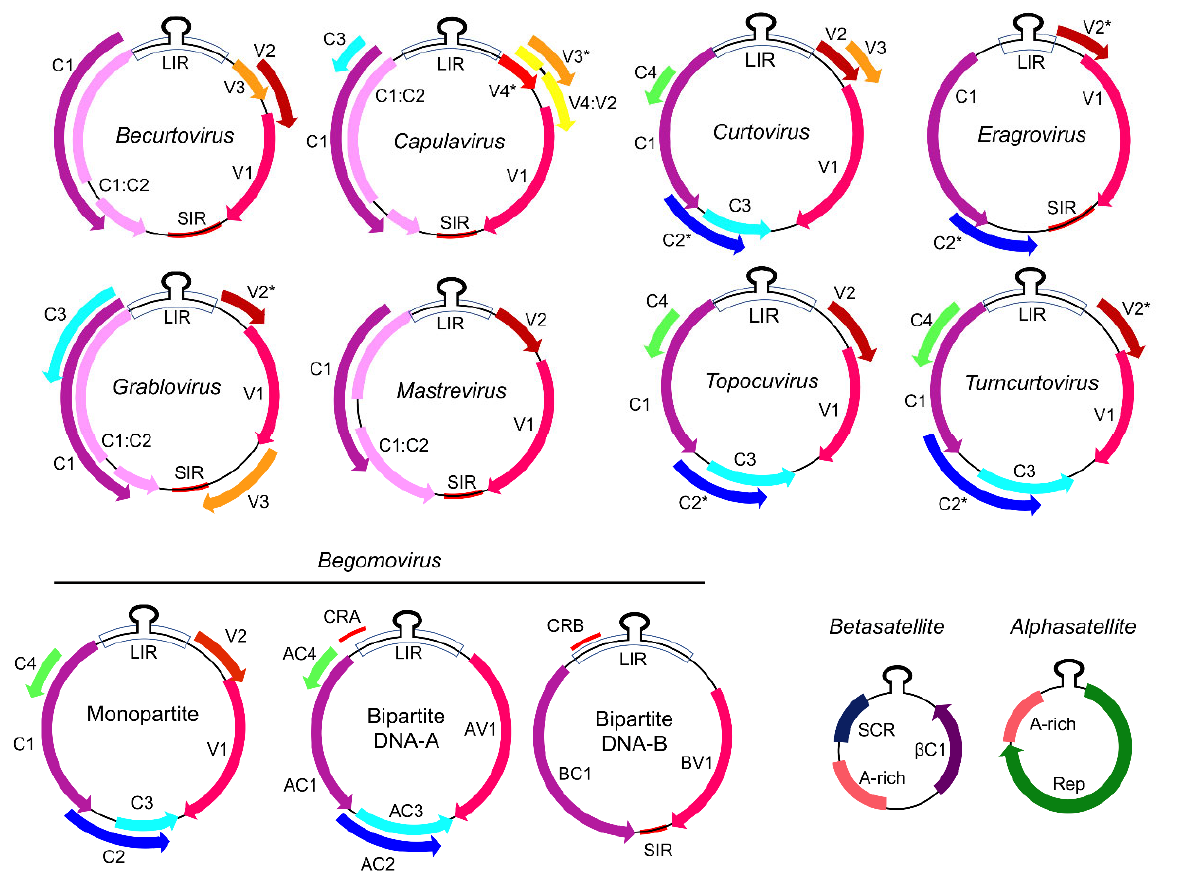
Figure 1. Genomic organization of geminiviruses (Geminiviridae family). The Geminiviridae family includes nine genera represented by monopartite or bipartite species. LIR denotes the long intergenic region; SIR, the short intergenic region; and CR, the common region. The open reading frame (ORF) C1/AC1 encodes the replication initiator protein (Rep) and C3/AC3 encodes the replication enhancer protein (Ren), which are associated with replication. The ORF C2/AC2 encodes a transcriptional activator protein (TrAP) that controls the transcription of viral and host genes; C4/AC4 is a virulence factor. The capsid protein (CP) is indicated in the monopartite and bipartite genomes, as V1 and AV1. In monopartite species, V2 represents the movement protein (MP). V3, present in some genomes, is an inhibitor of gene silencing. ORFs with asterisks have not been functionally assayed. In bipartite begomoviruses, MP (BC1) is encoded by the DNA ‐ B, which also encodes the nuclear shuttle protein, NSP (BV1), which facilitates the nucleocytoplasmic movement of viral DNA. Bipartite begomoviruses are often associated with ssDNA satellites, i.e., the alphasatellites, which encode a replication protein (Rep), and the betasatellites, which encode the virulence ‐ related β C1 protein. A ‐ rich is a conserved adenine rich region of the DNA satellites, and SCR is the satellite conserved region. Adapted from [1]